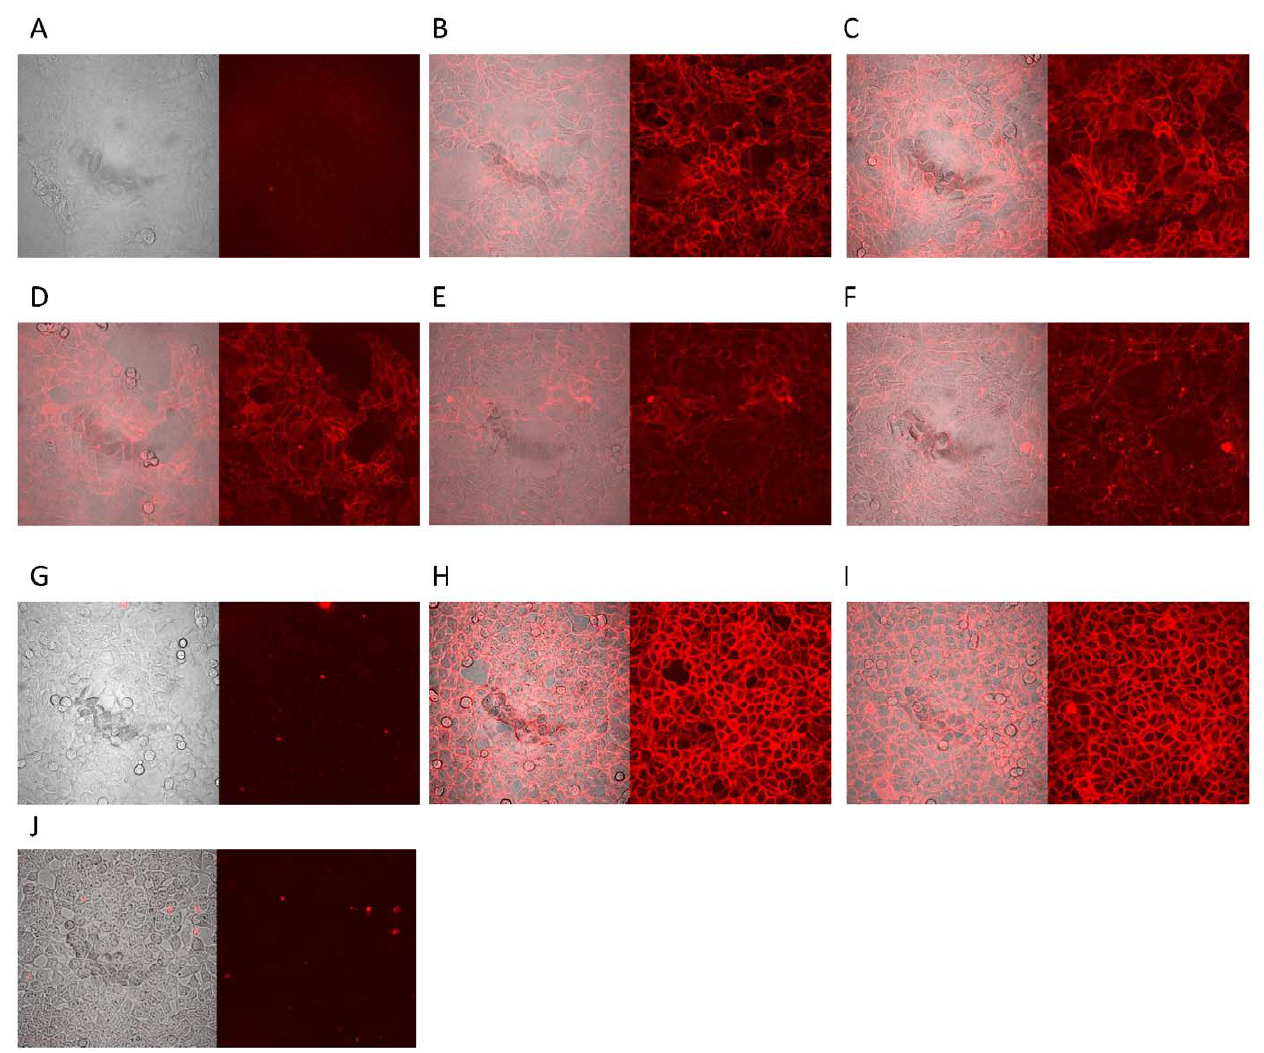
Figure 7. Confocal images of aptamers staining with cultured DLD-1 (A–F) and HCT 116 (G–J). Cells were incubated with aptamer conjugated with biotin and the binding event was observed with AlexaFluor 633 conjugated streptavidin. Unselected library shows the background binding. Aptamers show significant binding over the background signal. For DLD-1 cells, A= unselected library; B = KCHA10; C = KDED19; D = KC2D8; E = KDED18; F = KDED20 and for HCT 116 cells, G = unselected library; H = KCHA10; I = KC2D8 and J =